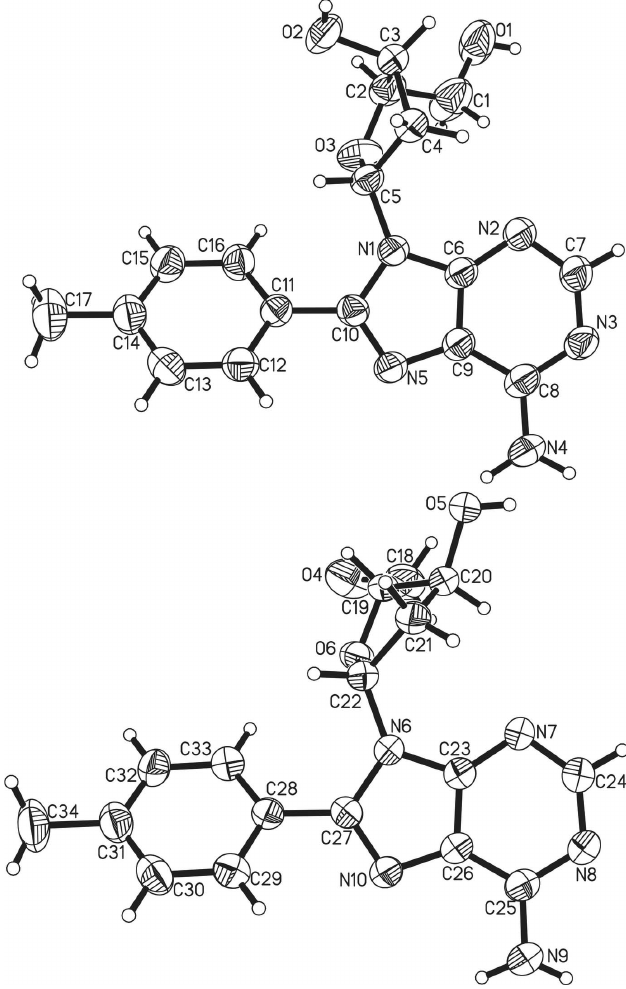
Figure 1 The two independent compound molecules of the asymmetric unit displayed in a comparable orientation to show the distinct conformation of the deoxyribosyl moiety (top: mole 1; bottom: mole 2). Displacement ellipsoids are shown at the 50% probability level.